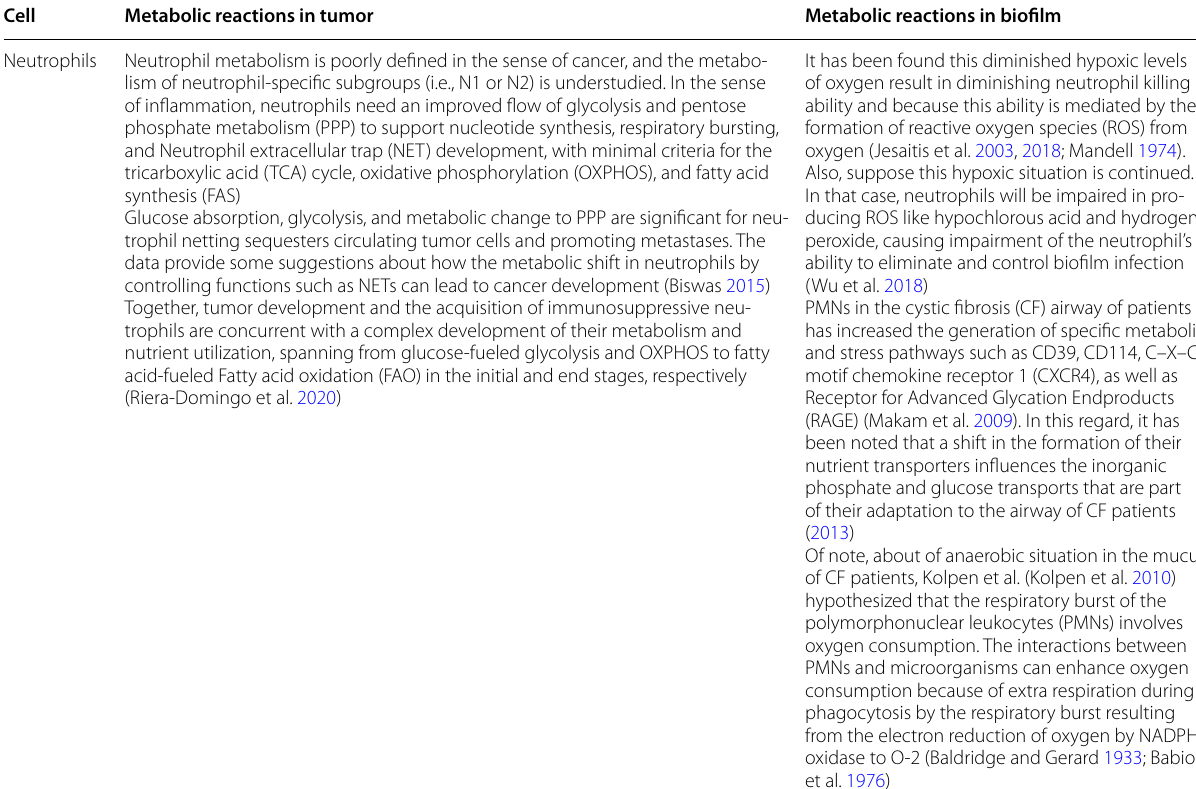
Table 3 Metabolic changes in immune cells during cancer and biofilm infection Cell Metabolic reactions in tumor Metabolic reactions in biofilm